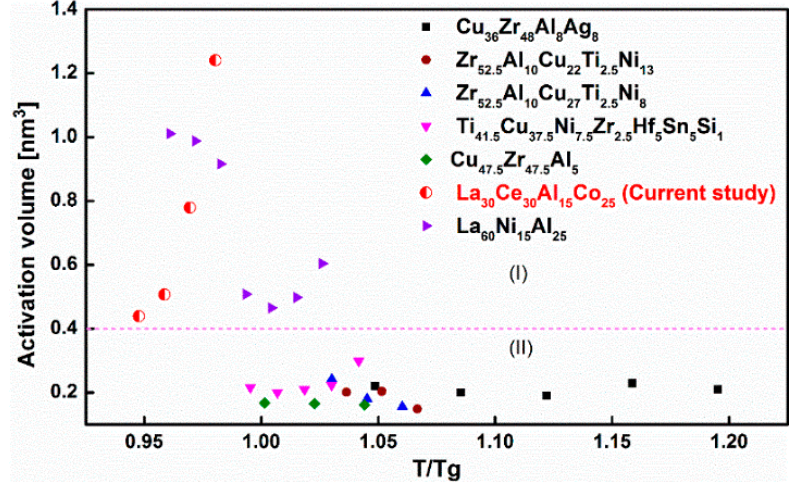
Figure 7. The activation volume varies with testing temperature for typical metallic glasses in high-temperature deformation (testing temperature around the glass transition temperature T g ). (I) La-based metallic glasses with pronounced β relaxation (II) other metallic glasses without obvious β relaxation. The activation volume data obtained in the present research and the previous literatures [37,38,45].